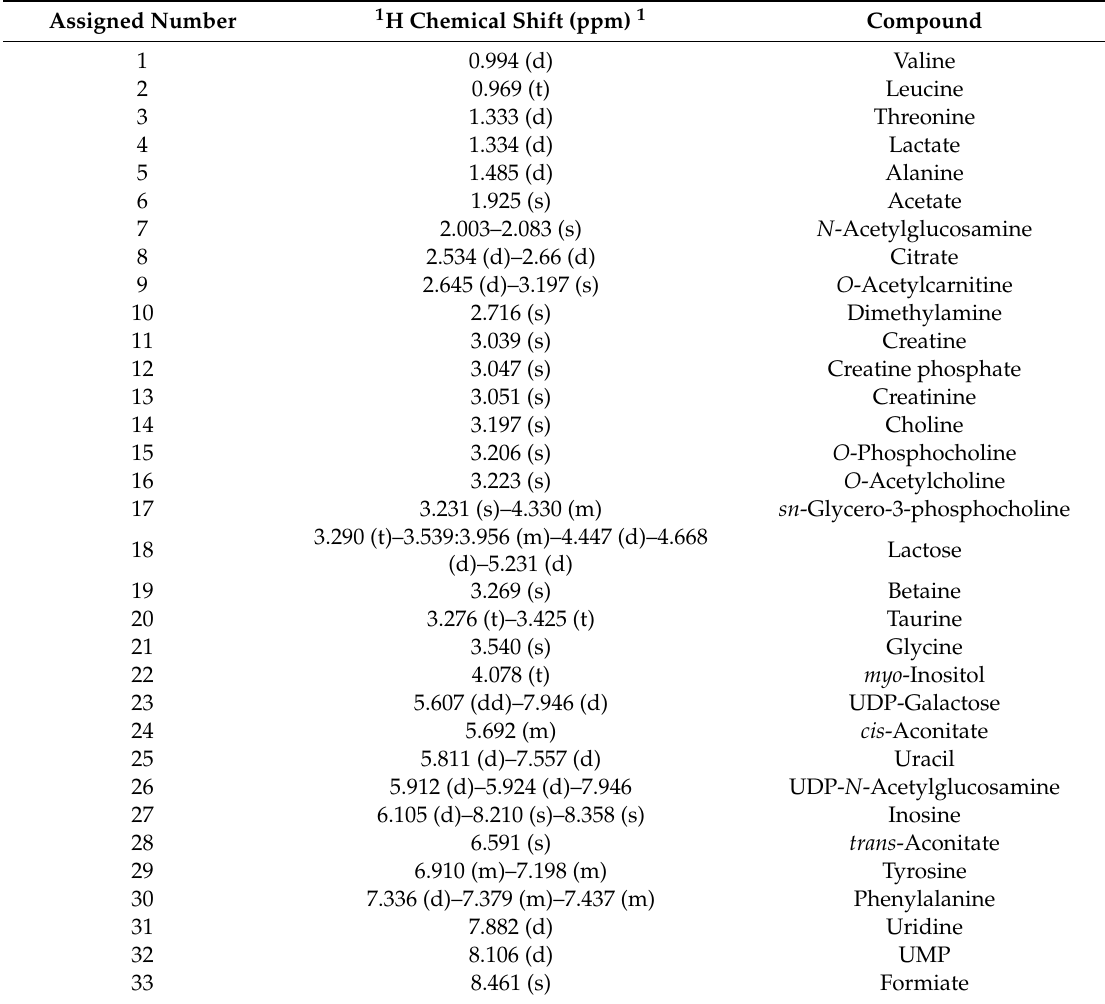
Table 2. Assignment table of the identified metabolites present in the 1 H-NMR spectra of swine